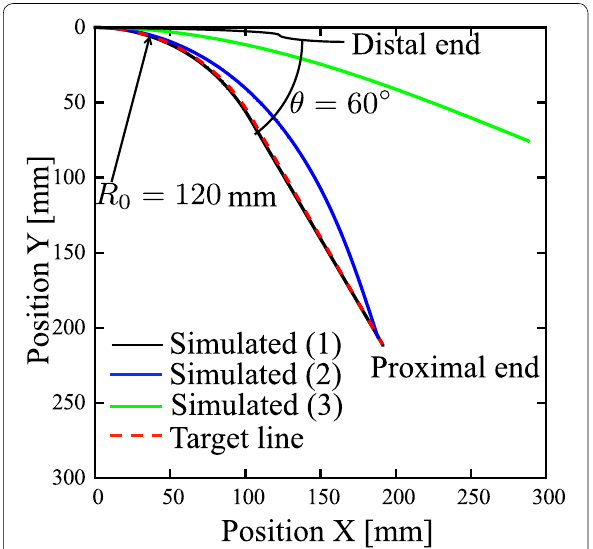
Fig. 8 Simulation results for the 6 mm inner